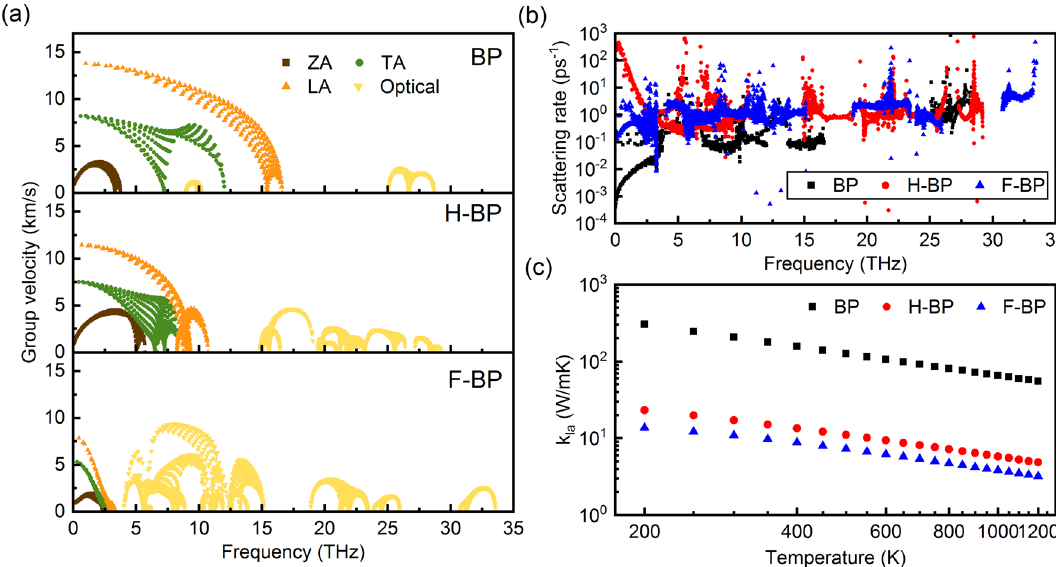
Figure 2. ( a ) Phonon group velocities v g and ( b ) scattering rates as a function of frequency; and ( c ) lattice thermal conductivity k la as a function of temperature for BP, H-BP and